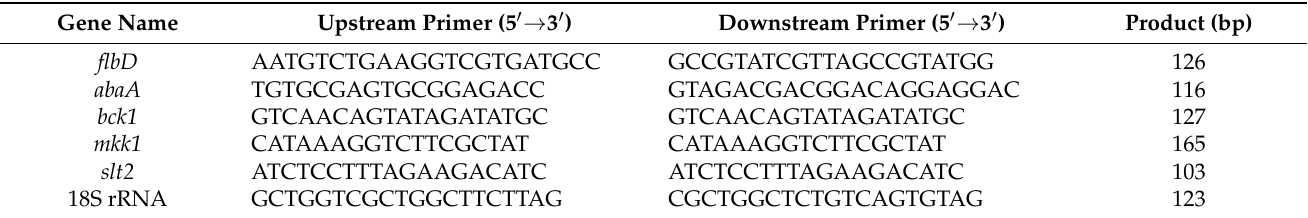
Table 1. Primers used for RT-qPCR.